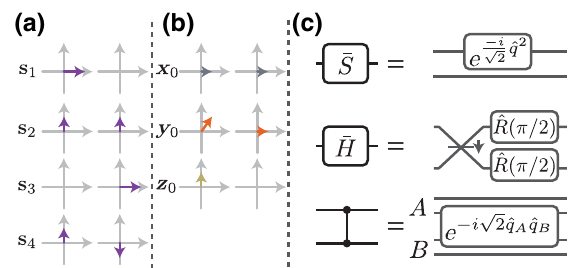
FIG. 2. Tesseract code. (a) Phase-space representation of the stabilizer generators. The left and right graphs represent the pro- jection onto the ( q , p ) phase space of the first and second mode, respectively. (b) Similar representation for the logical operators.